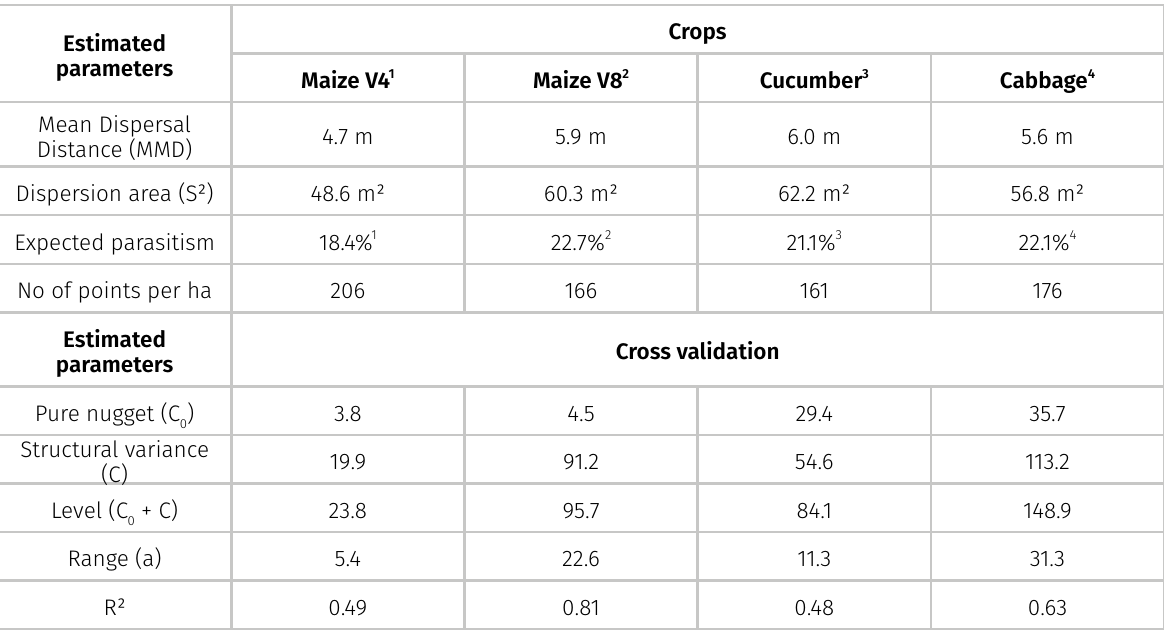
Table I. Mean distance, dispersal area, expected parasitism, parameters of the fitted, and cross validation of the interpolated data by the ordinary Kriging method for parasitism of Trichogramma pretiosum (Hymenoptera: Trichogrammatidae) on Anagasta kuehniella (Lepidoptera: Pyralidae) eggs in the sweet corn, cucumber and cabbage, “Guaraciaba do Norte”, Ceará